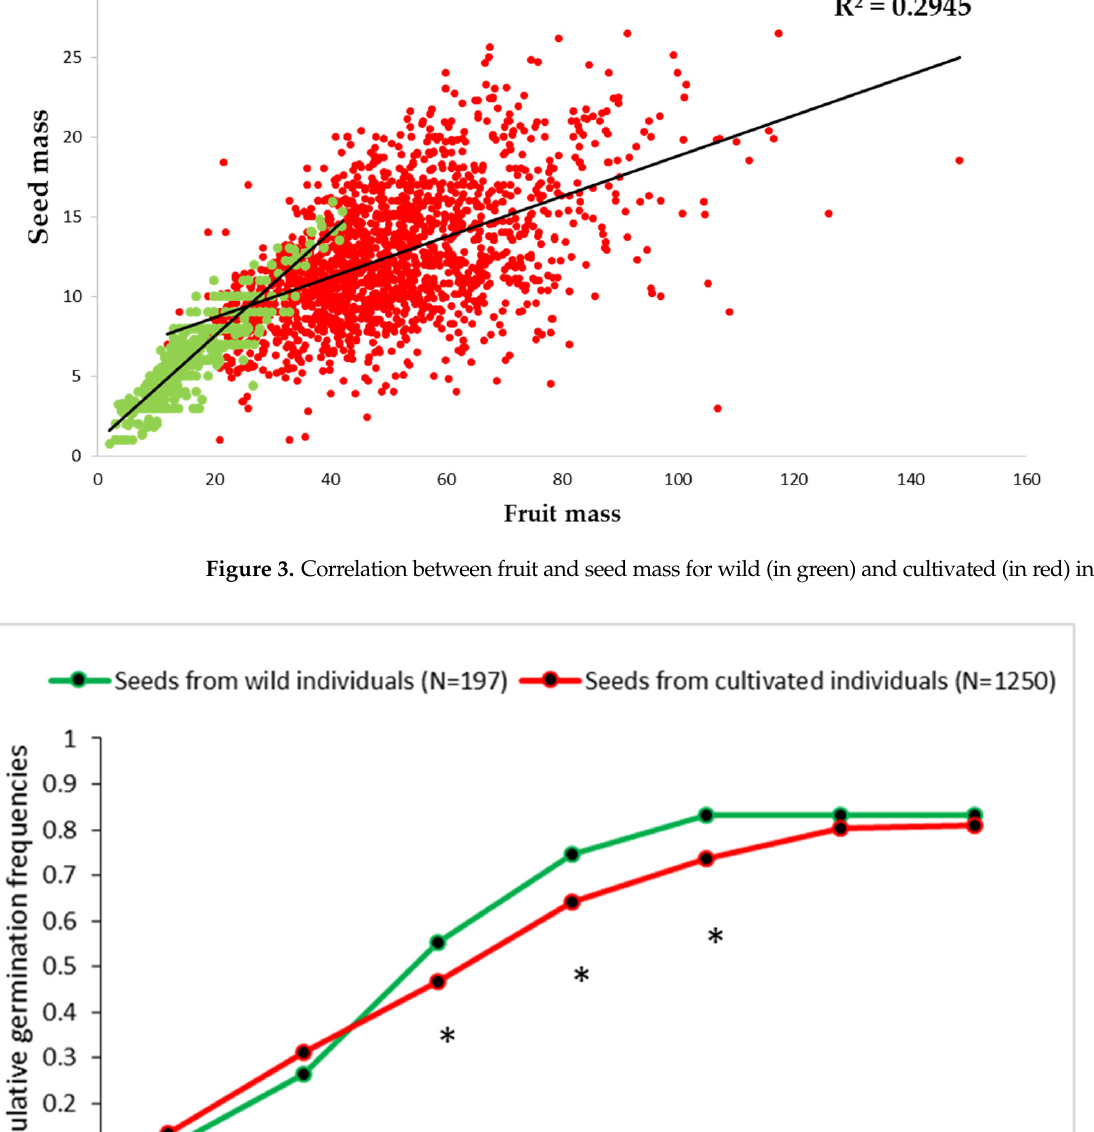
Figure 3. Correlation between fruit and seed mass for wild (in green) and cultivated (in red) indi-